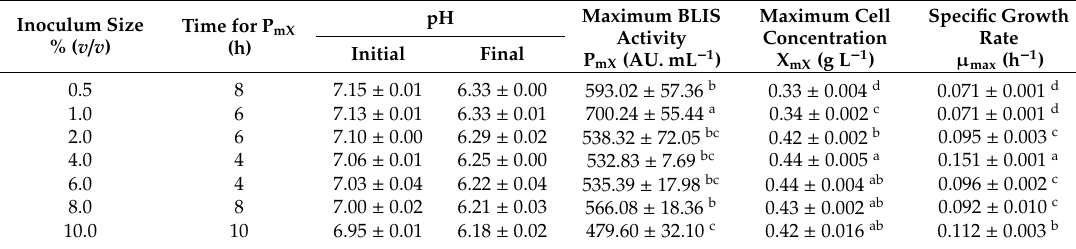
Table 5. Growth of L. lactis Gh1 and BLIS production using BHI medium, inoculated with di ff erent sizes of inoculum. The inoculum was set at mid-exponential phase.